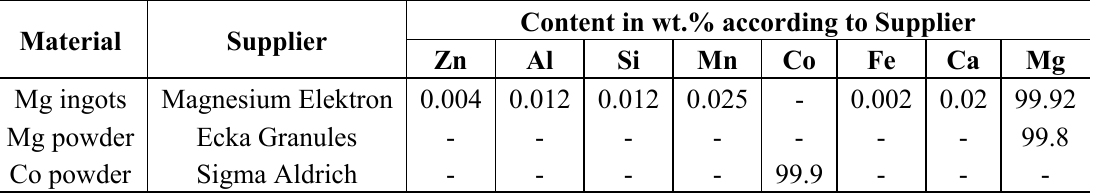
Table 1. Materials used in this